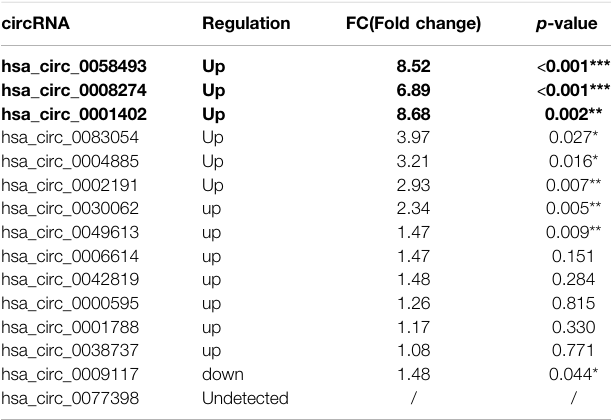
TABLE 2 | Differential expression of top 15 up-regulated circRNAs in imatinib- resistant cell lines K562/G01 vs imatinib sensitive cell lines K562 circRNA Regulation FC(Fold change)